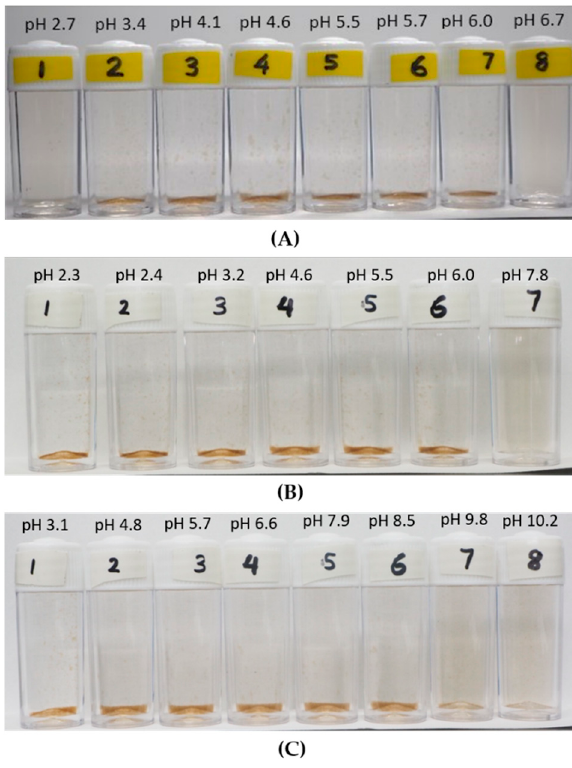
Figure 4. Aggregation of LSZ–LHA complexes on mass ratio C LSZ / C LHA = 2.5 at 3 mM ( A ), 10 mM ( B ), and 50 mM KCl ( C ) concentration under various pHs. The time frame for all images is at 24 h.